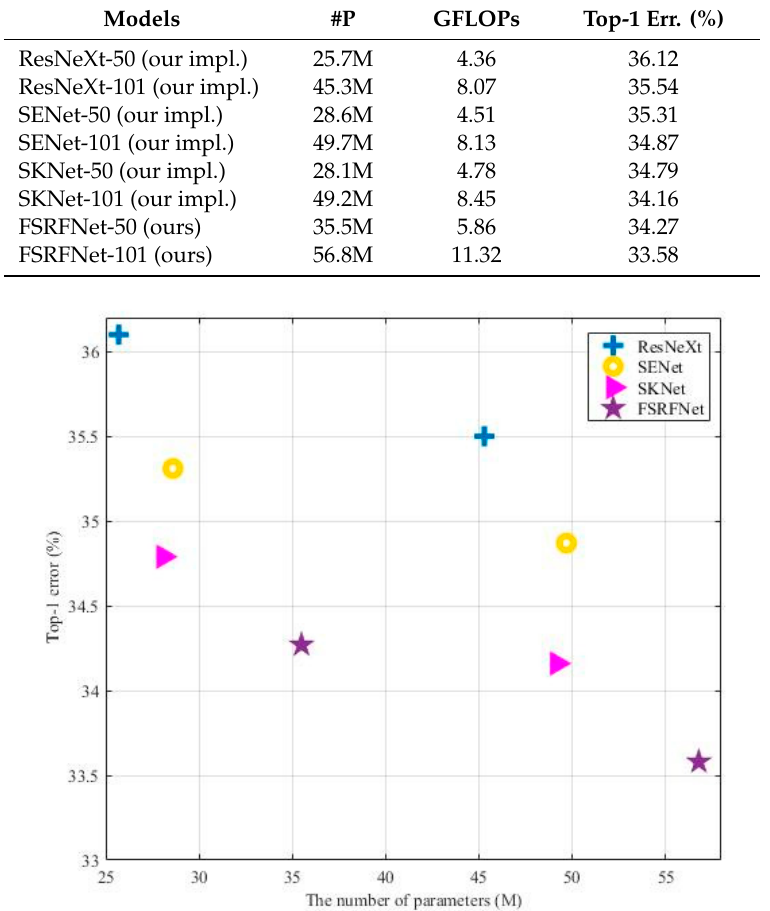
Table 3. Single 224 × 224 cropped top-1 error rates (%) on the Tiny ImageNet validation set and complexity comparisons, with all models based on the corresponding ShuffleNetV2.